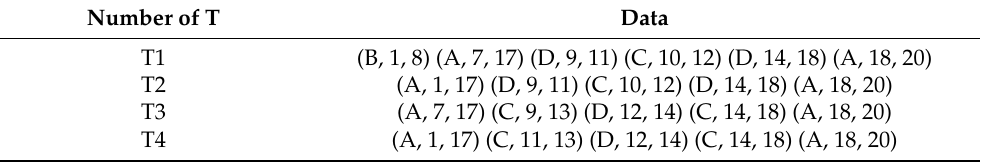
Table 2. Dataset D2.